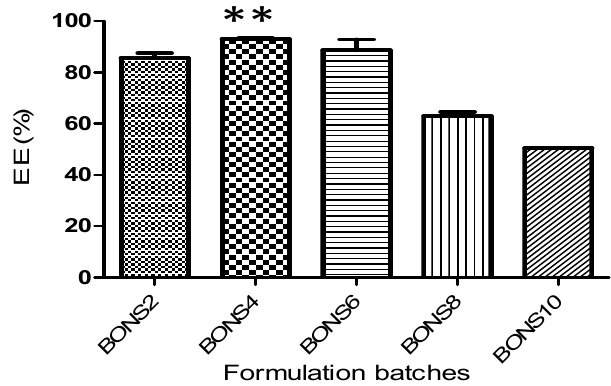
Figure 2. Encapsulation efficiency of the nanosponges (NS2–NS10). Statistical data analysis from a one-way ANOVA (and nonparametric) Kruskal-Wallis test (Encapsulation effeciency: Kruskal-Wallis statistics: 16.97) was followed by a Dunn’s multiple comparison test (** p < 0.01 versus BONS10).